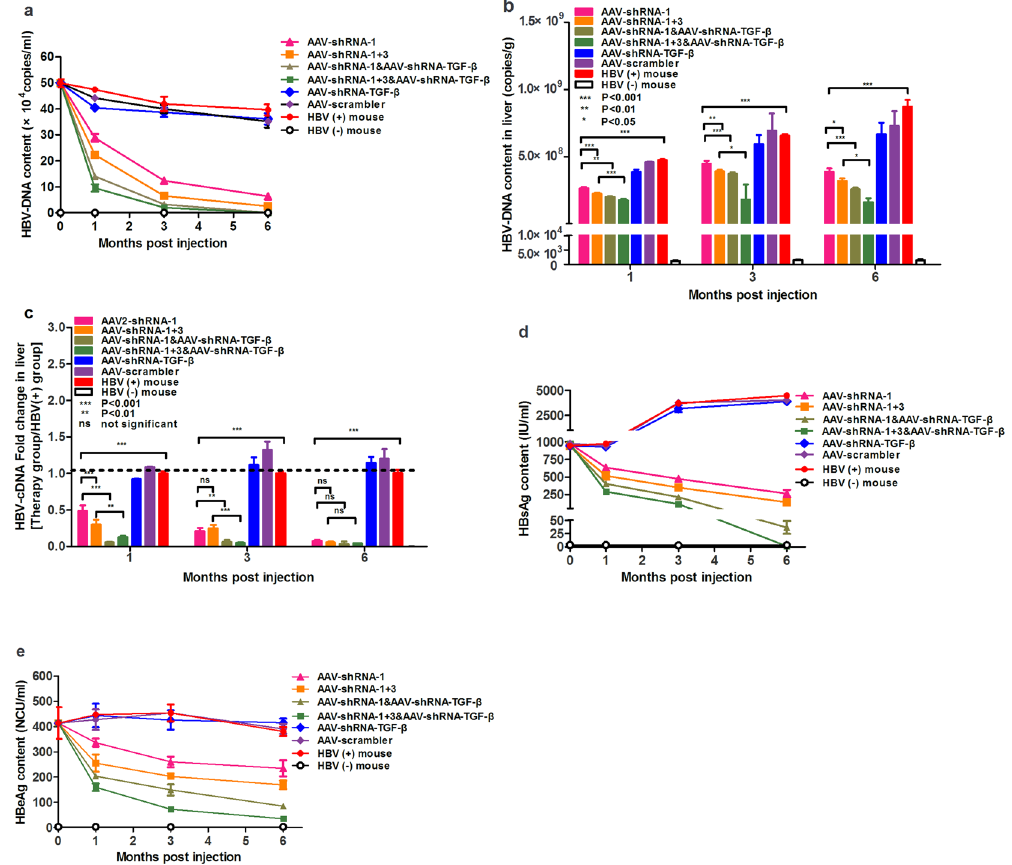
Figure 4. AAV-shRNA inhibits HBV replication and expression in HBV-persistent mice. Mice received AAV2-shRNA treatment, and serum and liver samples were collected at the indicated time points during a 6 month period. HBV DNA levels in serum ( a ) and liver tissues ( b ) were measured by qPCR, and HBV RNA levels were quantified by RT-qPCR ( c ). Serum HBsAg ( d ) and HBeAg ( e ) were measured by ELISA. P < 0.05: significant difference, Data represent the mean ± SD. HBV( + ) mice, HBV-persistent mice with administration of PBS; HBV( − ) mice, wild-type mice injected with PBS; AAV-scrambler, HBV-persistent mice treated with AAV2-scrambler, a vector carrying a scrambled shRNA sequence not targeted to the HBV genome; AAV- shRNA-1, HBV-persistent mice treated with an AAV2 vector carrying the single shRNA-1 against HBV; AAV- shRNA-1 + 3, HBV-persistent mice treated with an AAV2 vector carrying shRNA-1 and shRNA-3 against HBV; AAV-shRNA-TGF- β , HBV-persistent mice treated with AAV2-shRNA against TGF- β